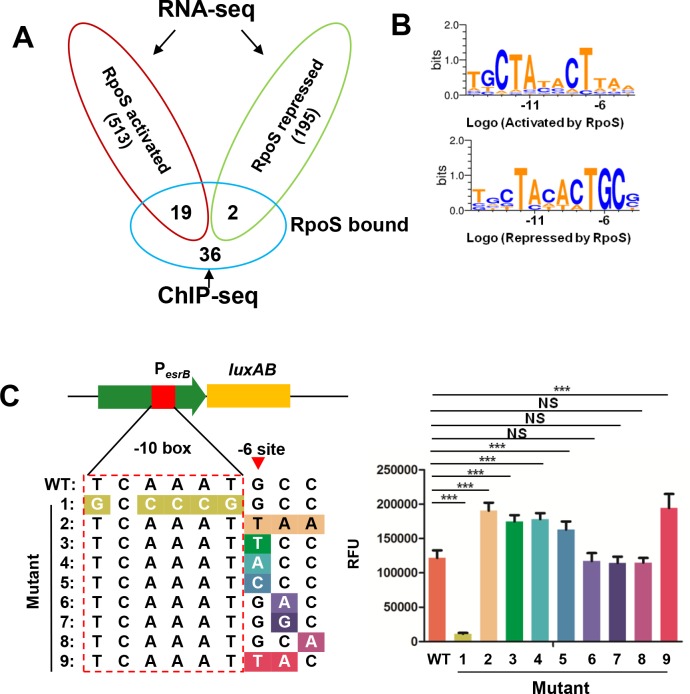
The -6G in the discriminator sequence of RpoS controlled promoters is required for RpoS to act as a repressor.(A) Venn diagram showing genes directly bound and regulated by RpoS as revealed by RNA-seq and ChIP-seq analysis. (B) RpoS binding motifs on activated and repressed genes. (C) A promoterless luxAB reporter was fused to WT and mutant PesrB (left panel), cloned into plasmid pUTat and introduced into the WT strain. The fluorescence of the respective strains was assayed at 9 h (right panel). *** P < 0.0001, NS, non-significance (P >0.05) based on student’s t-test.